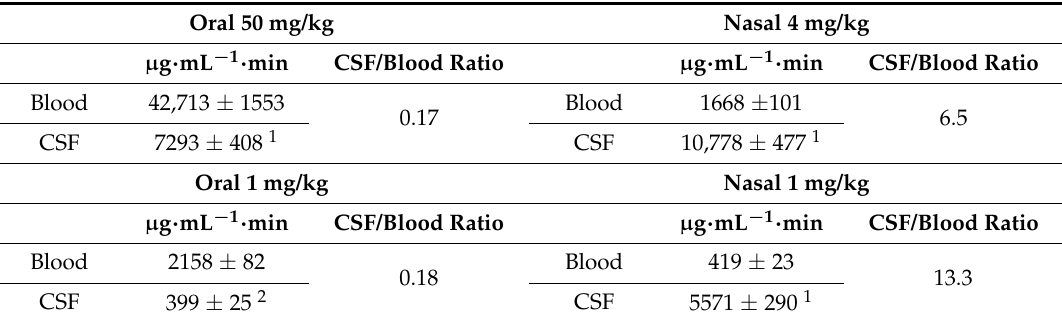
after the nasal administration of 4 mg/kg geraniol formulated as G-CS-OA-2.0% emulsion. The rat blood geraniol concentrations were 36 ± 5 µg/mL and 23 ± 4 µg/mL 15 and 75 min after administration; moreover, 6 µg/mL were detected at the 90 min time point. On the other hand, a maximum concentration peak ( C max ) of 184 ± 18 µg/mL was obtained in the CSF 30 min after the